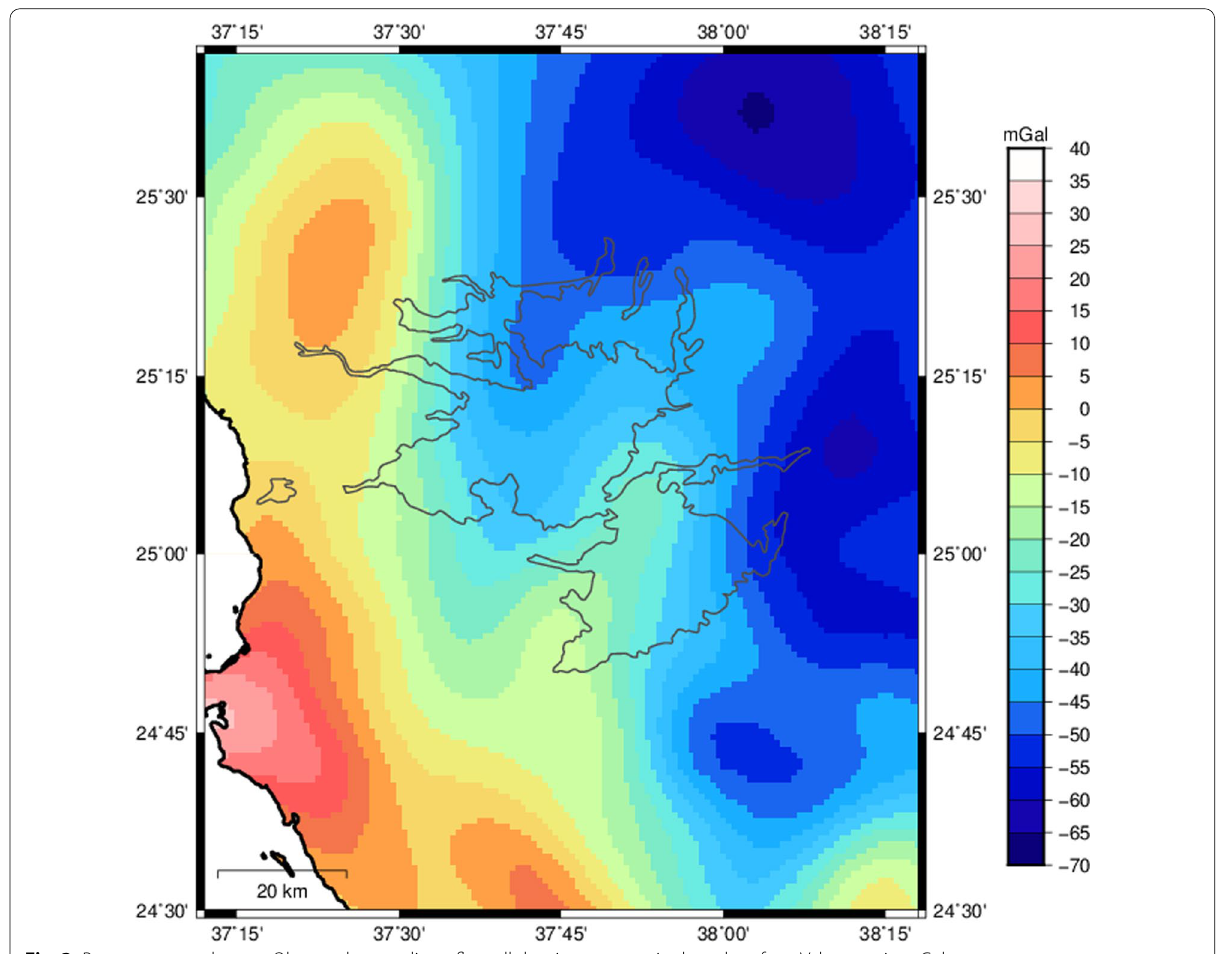
Fig. 3 Bouguer anomaly map. Observed anomalies reflect all density contrasts in the subsurface. Values are in